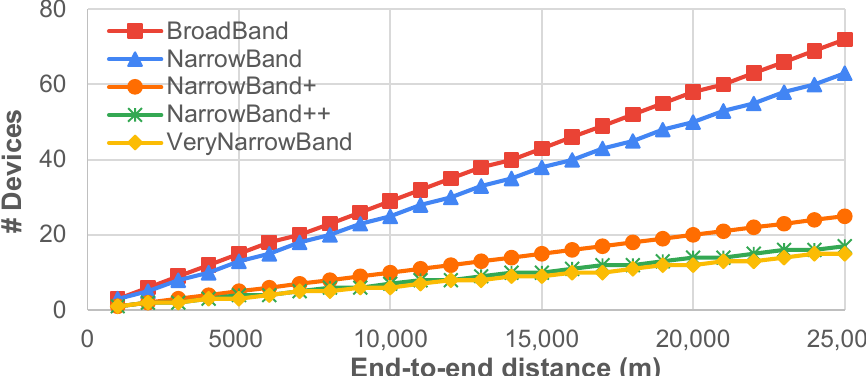
Figure 10. No. of intermediate nodes to ensure no-loss multi-hop